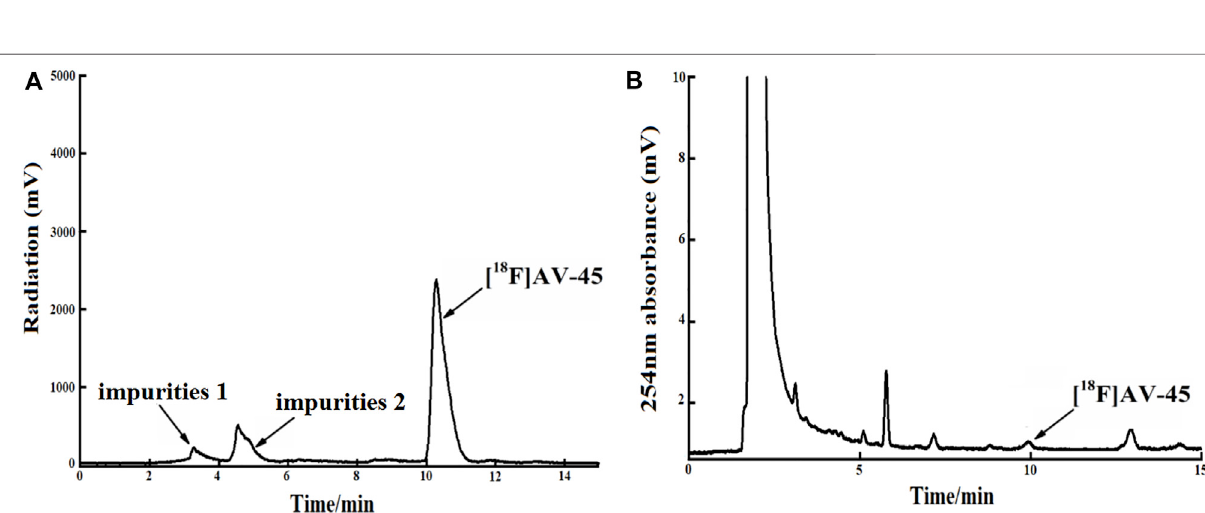
Frontiers in Chemistry |